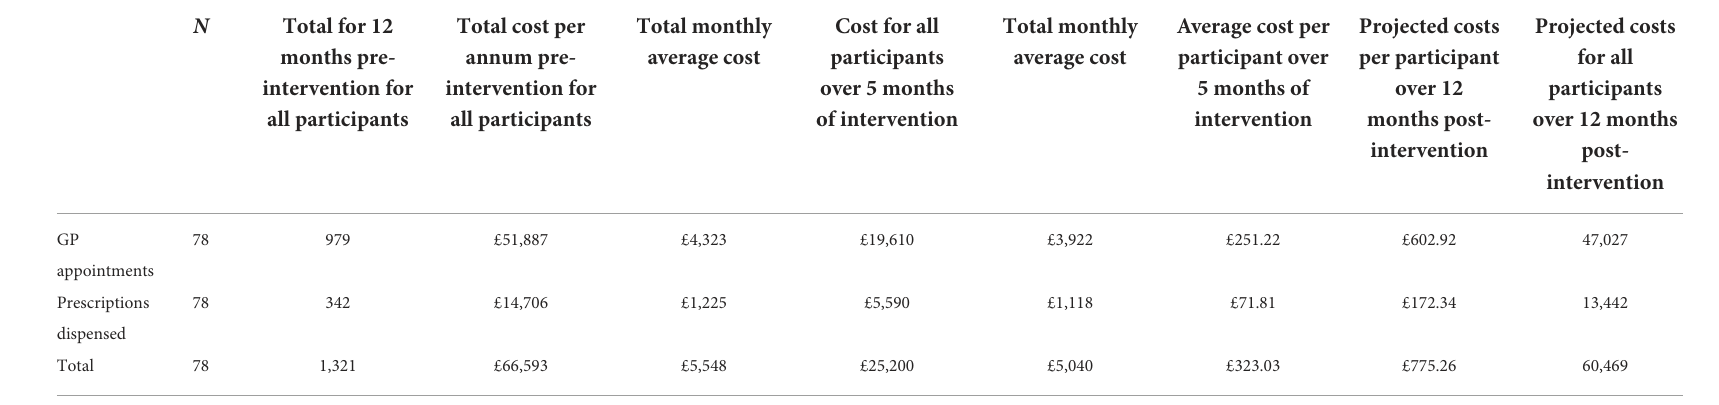
TABLE 3 Healthcare unit costs for entire cohort.